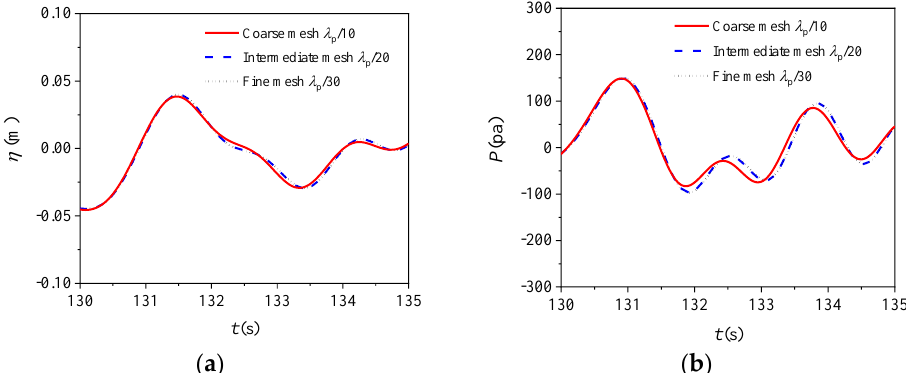
Figure 3. Time histories of the ( a ) surface elevations at chamber center and ( b ) pneumatic pressures in the chamber for different mesh sizes.